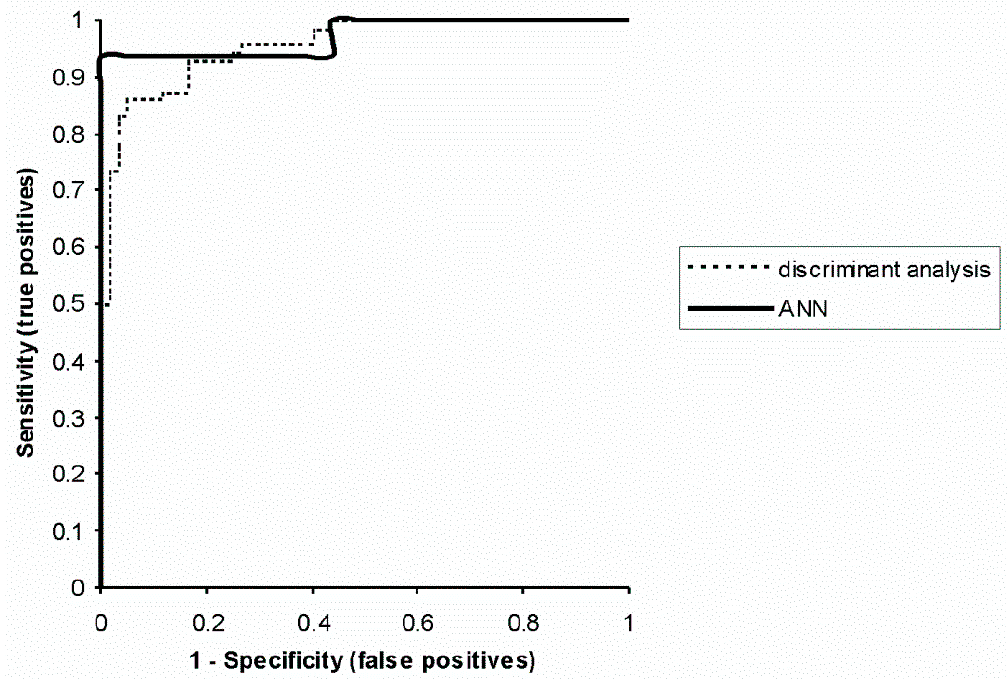
Figure 2. Receiver operating characteristic (ROC) curves for the artificial neural network (ANN) and discriminatory analysis.